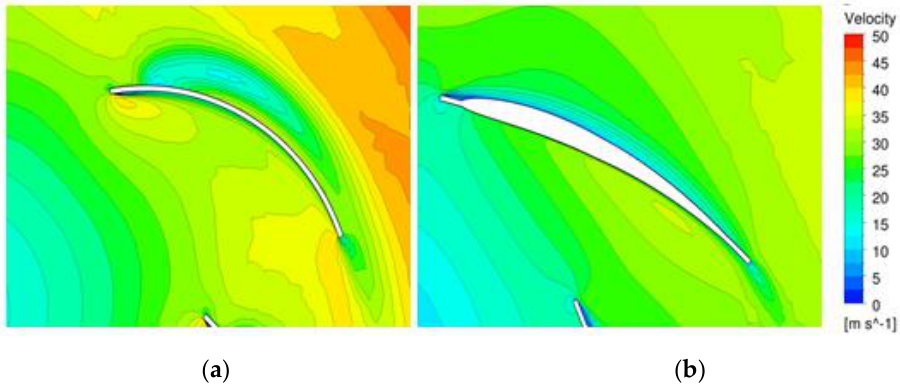
Figure 14. Velocity distribution (at 1100 rpm): ( a ) Original model; ( b ) Optimized model.